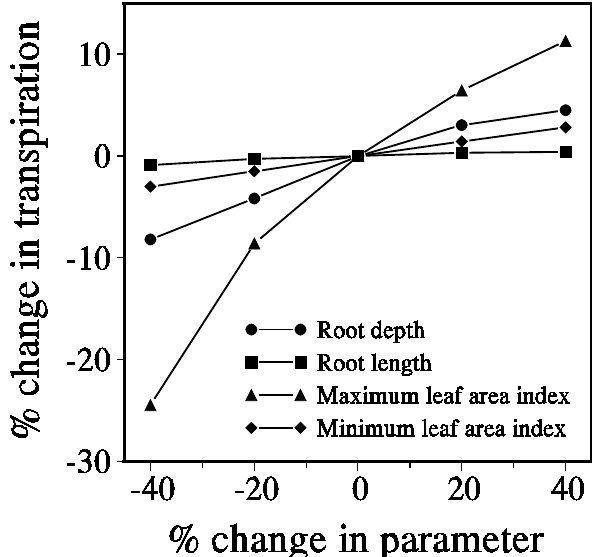
Fig. 9. Comparison of simulated runoff ratio (percola- tion/precipitation) with measured stream discharge/precipitation ra- tios (HCD database http://pubs.usgs.gov/wri/wri934076/1st page. html) (numbers on symbols refer to sites listed in Table